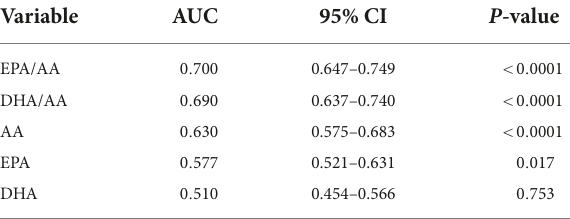
TABLE 4 ROC curves of serum EPA, DHA, AA and their ratios for diagnosis of CAD in young